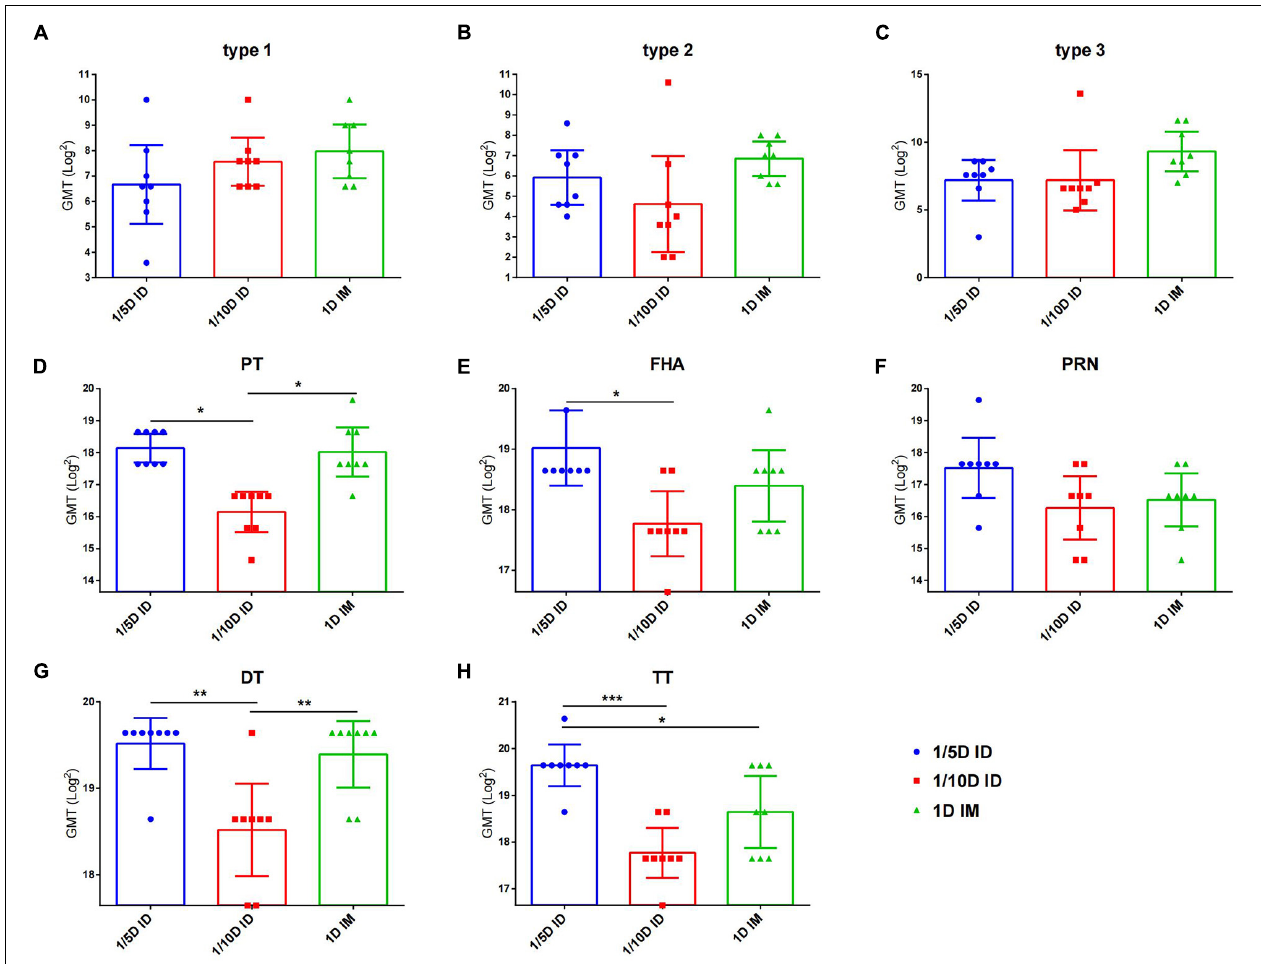
FIGURE 4 | After 6 months of vaccination, intradermal immunization induced the same antibody levels as the full-dose of the intramuscular immunization did. Six months after the last dose of immunization, serum antibody levels in unchallenged rats were examined to reflect the long-term protection induced by different vaccines. Virus neutralizing antibody titers for (A) type 1, (B) type 2 and (C) type 3, respectively. The results were shown as the log2 of virus neutralizing titers of the geometric mean ± 95% CI. Total IgG serum antibody were quantified against (D) PT, (E) FHA, (F) PRN, (G) DT and (H) TT at 28 days after each dose of immunization. The results were shown as the log2 of antibody titers of the geometric mean ± 95% CI. The PBS group results were below the detection limit and are not shown in figure. Data were analyzed using an one-way ANOVA model with Tukey’s multiple comparisons test. * P < 0.05, ** P < 0.01, and *** P < 0.001 ( n =